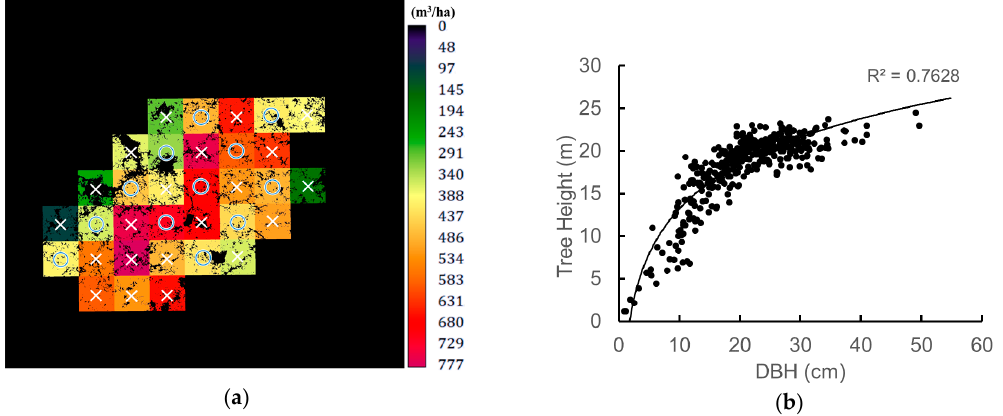
Figure 6. ( a ) Total stem volume per grid (m 3 /ha) and ( b ) the tree height–DBH relationship curve for the trees within the sample grids (n = 403). Shadow and canopy gaps are masked out in the raster image. The crosses and circles on each grids indicates the plot area used for training (21 plots) and validation (12 plots), respectively.